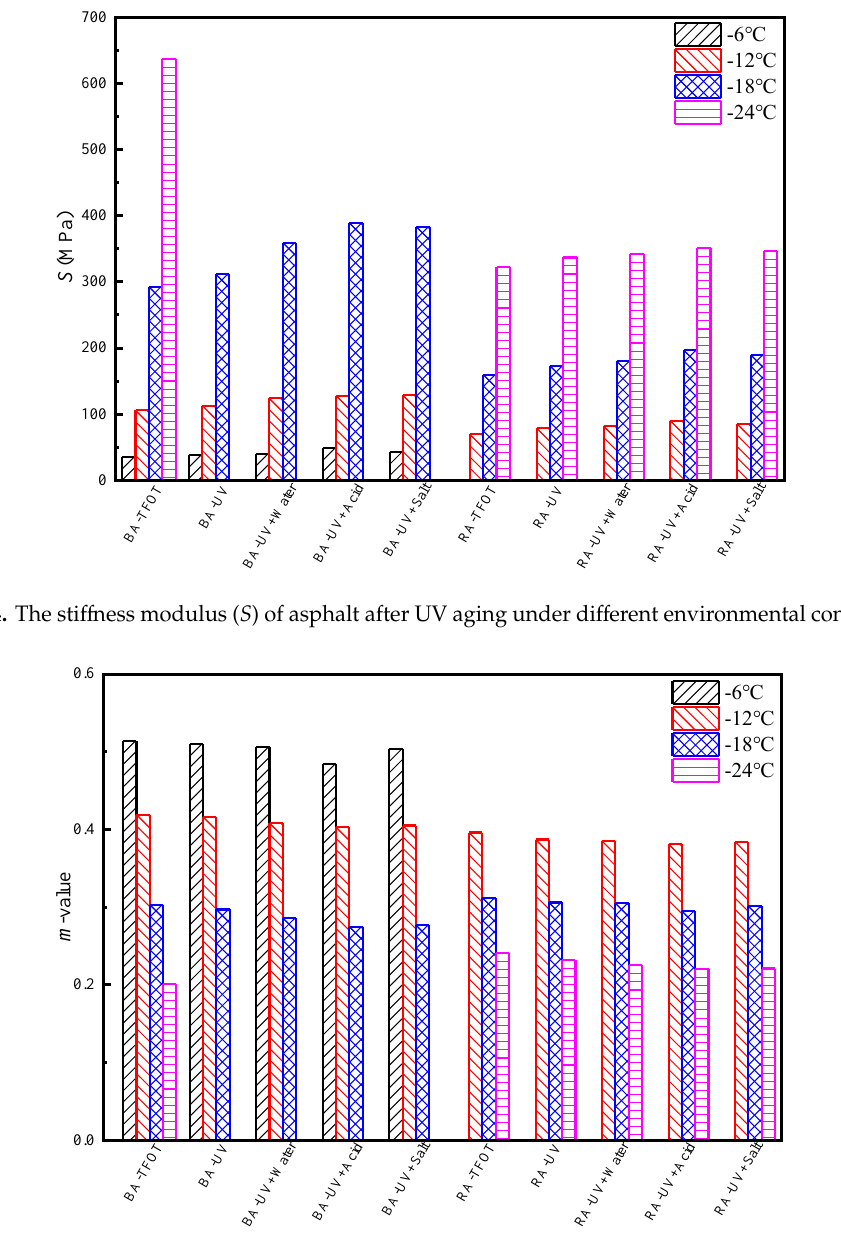
Figure 5. The creep rate ( m -value) of asphalt after UV aging under different environmental conditions.